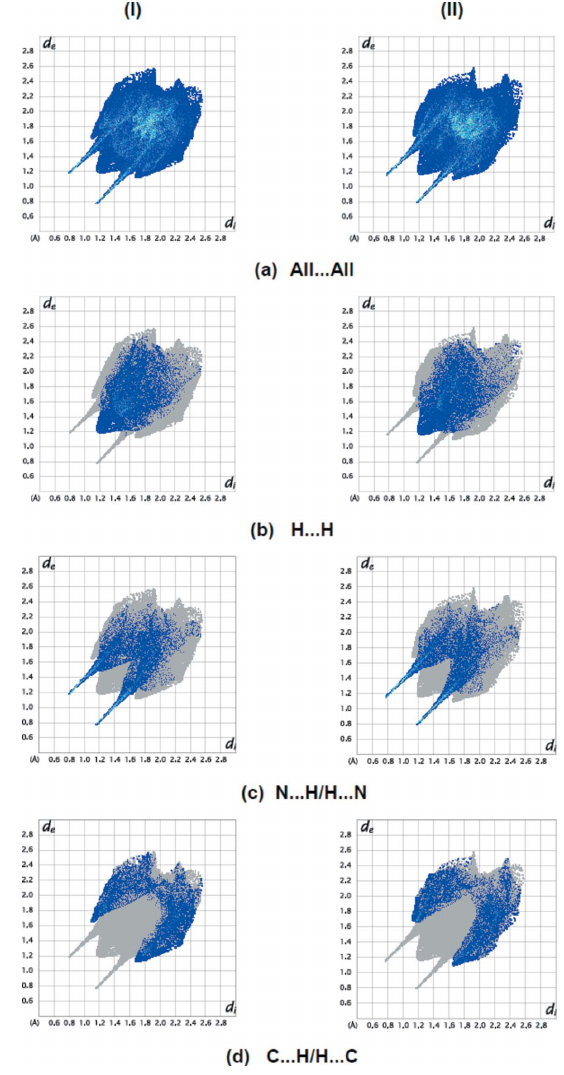
Figure 7 The two-dimensional fingerprint plots for molecules I and II of the title compound showing ( a ) all interactions, and delineated into ( b ) H (cid:2)(cid:2)(cid:2) H, ( c ) N (cid:2)(cid:2)(cid:2) H/H (cid:2)(cid:2)(cid:2) N and ( d ) C (cid:2)(cid:2)(cid:2) H/H (cid:2)(cid:2)(cid:2) C interactions. The d i and d e values are the closest internal and external distances (in A˚ ) from given points on the Hirshfeld